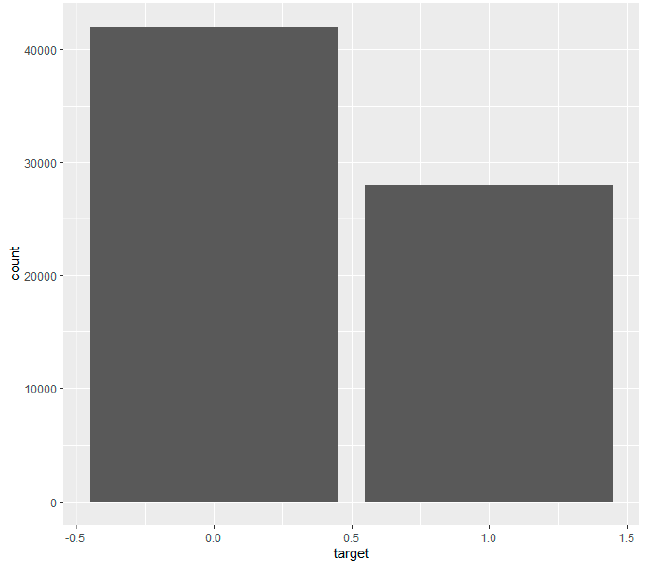
Figure 6. Histogram of the balanced distribution of target values after using the ROSE package in R.